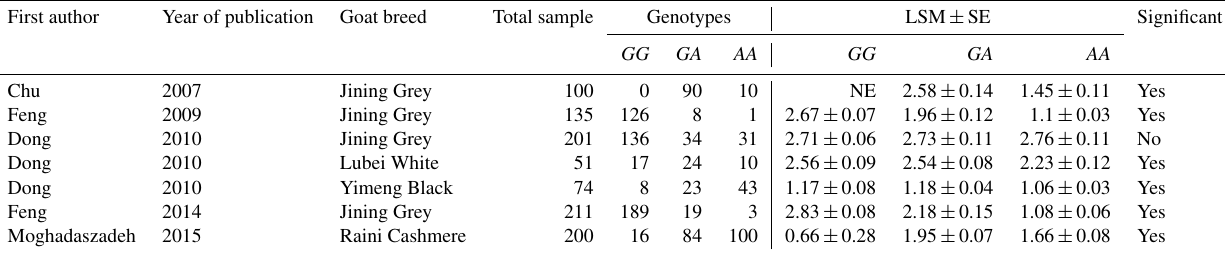
Table 1. Characteristics of studies included in this meta-analysis.